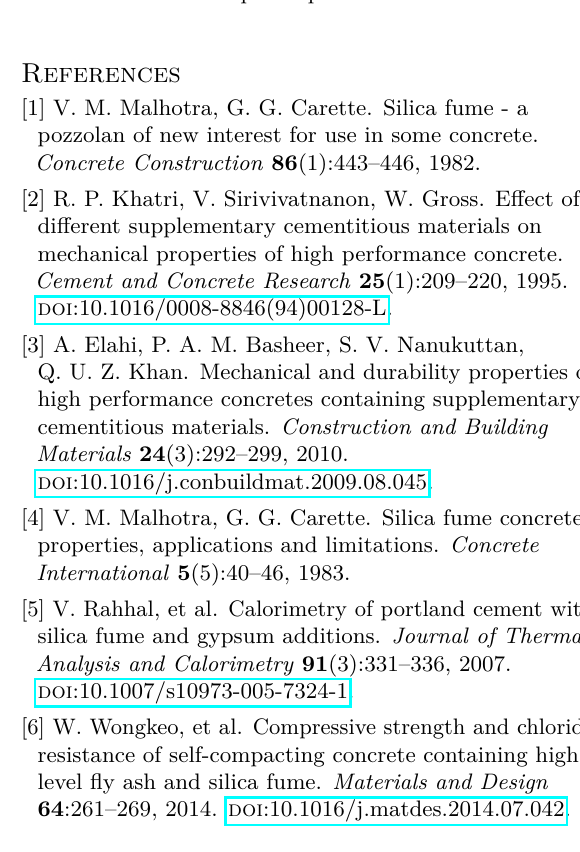
Table 3. Average percentage representation of individual composite